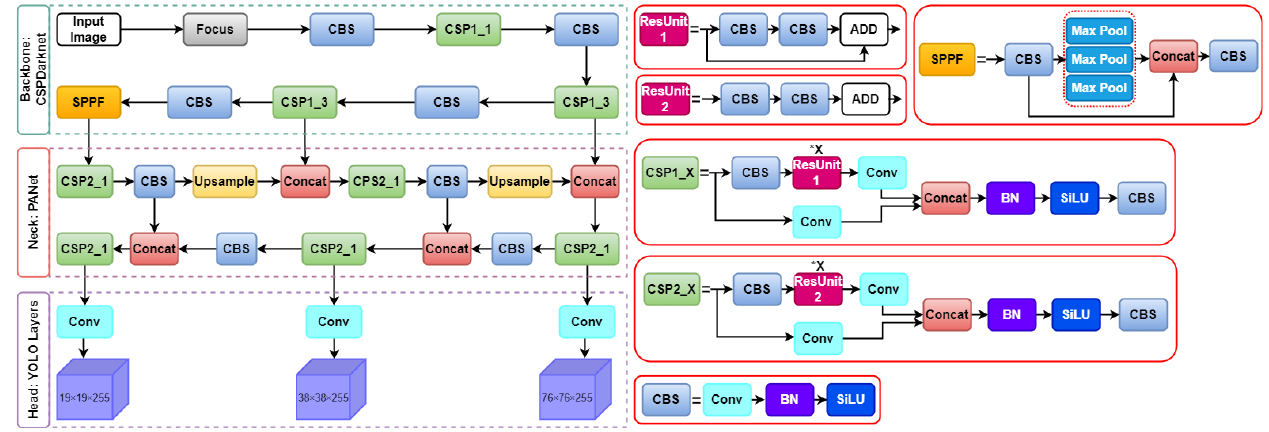
Figure 3. The network architecture of original YOLOv5 model.